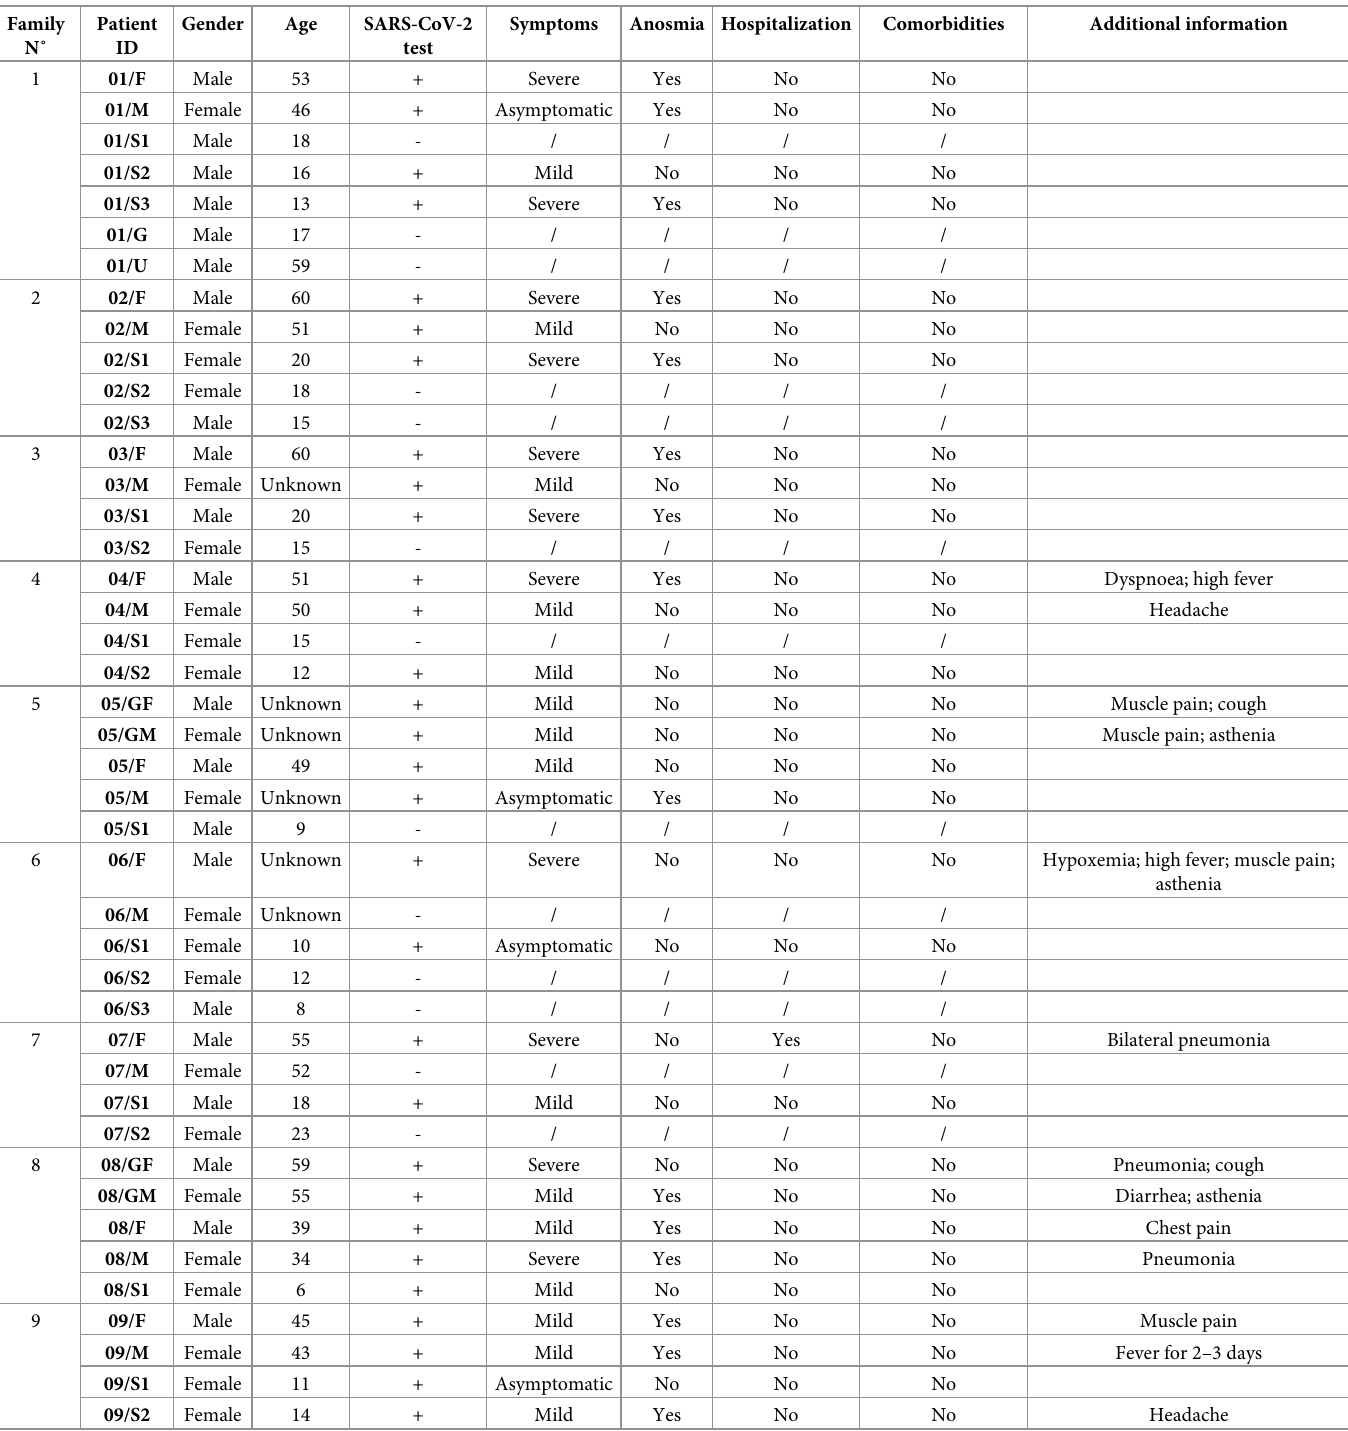
Table 1. Clinical features of our